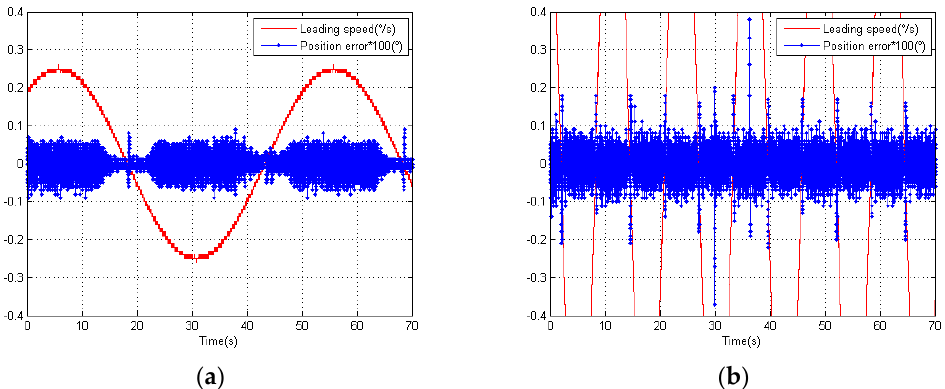
Figure 14. ( a ) Distribution of the compensated position error after adding the feed-forward loop with a leading speed of 0.25°/s; ( b ) Distribution of the compensated position error after adding the feed-forward loop with a leading speed of 1°/s.